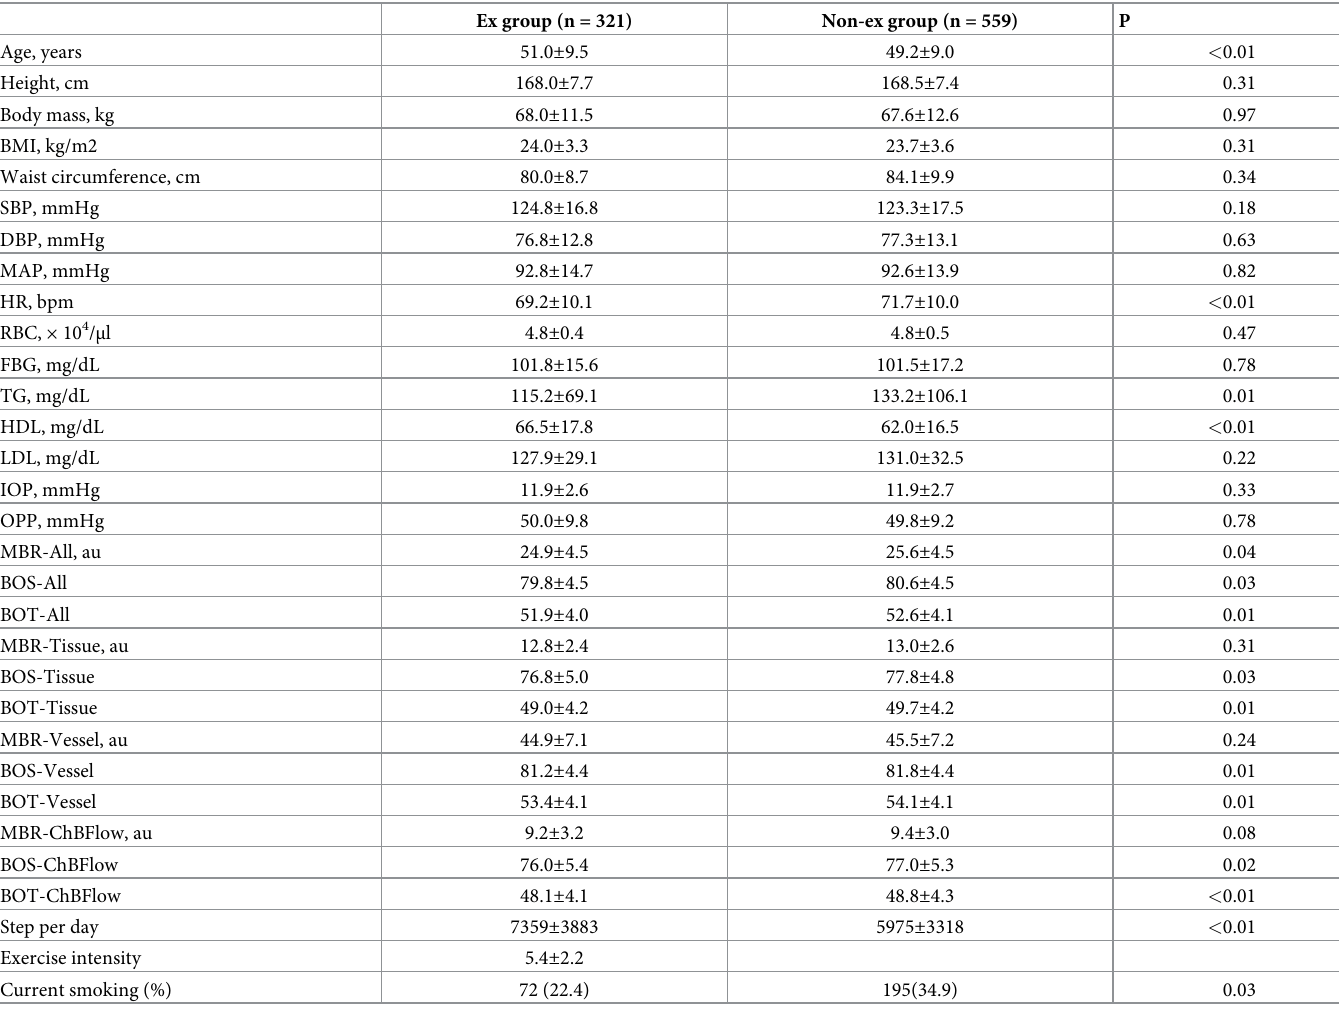
Table 2. Characteristics categorized by the self-reported Ex and Non-ex